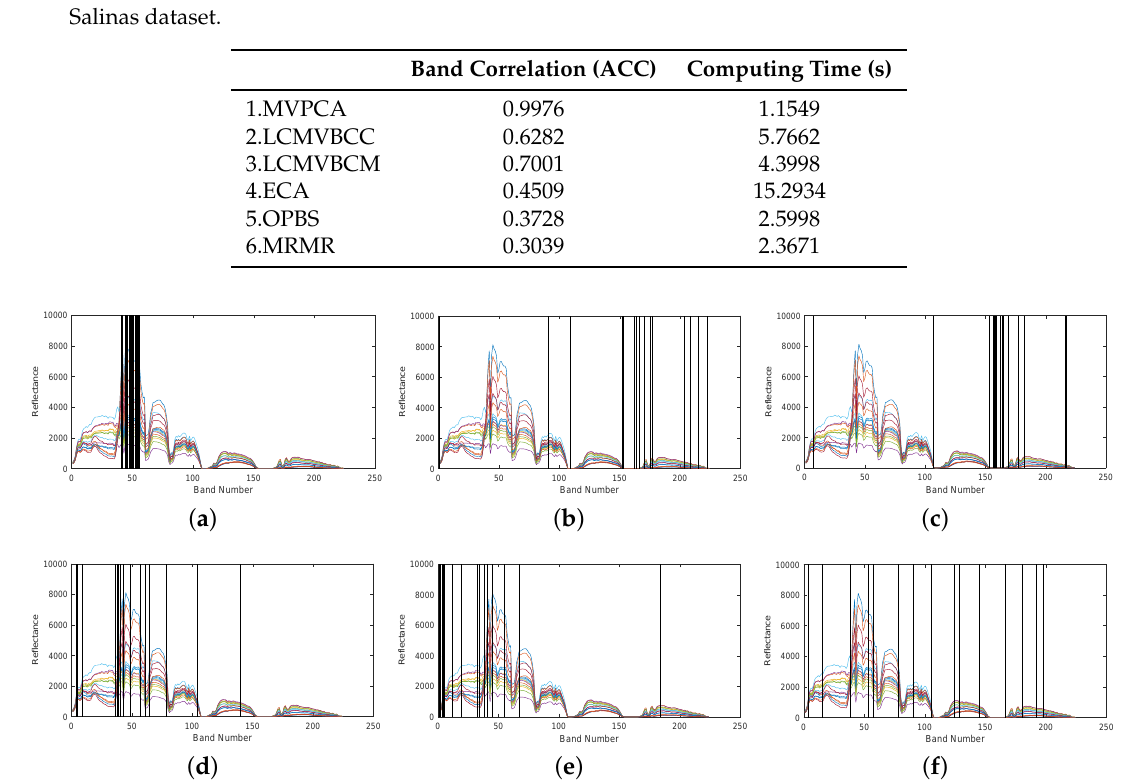
Figure 17. Spectrums of the categories on the Salinas dataset. The straight lines denote the bands selected by different BS methods. ( a ) MVPCA ( b ) LCMVBCC ( c ) LCMVBCM ( d ) ECA ( e ) OPBS ( f )